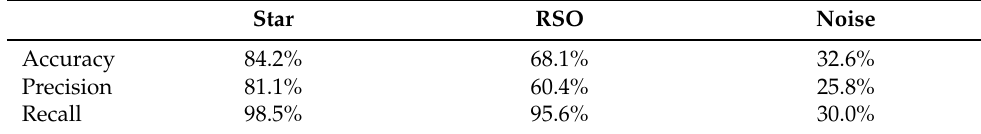
Table 2. Tracking and classification performance